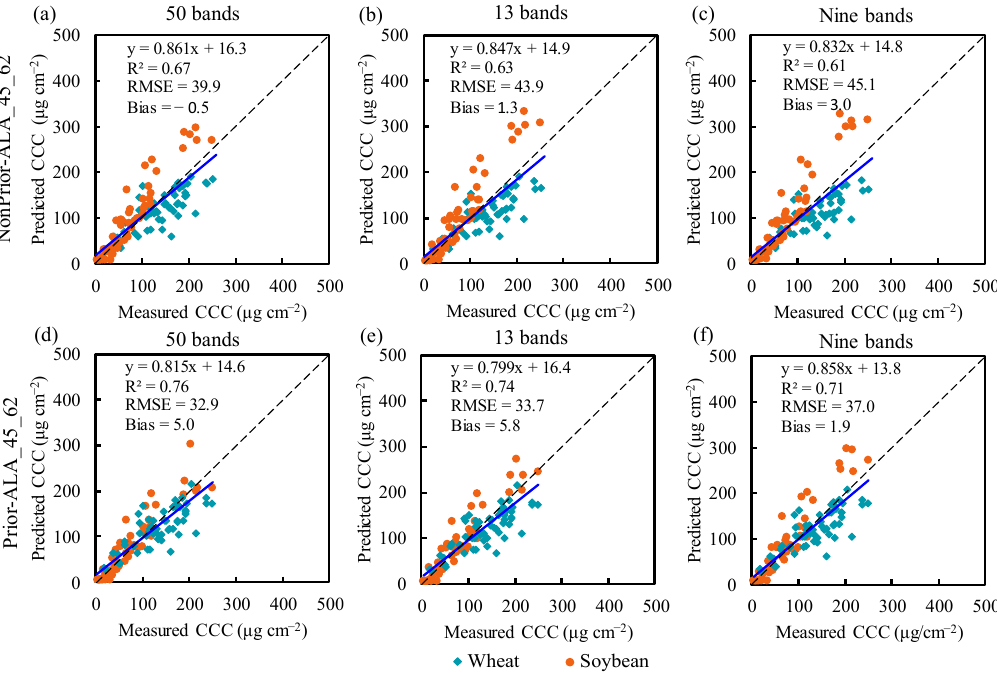
Figure 5. Scatter plots of the ground-measured and predicted CCC based on the RFR model using continuous and discrete spectra. Above: results of NonPrior-ALA_45_62 model using ( a ) 50 bands, ( b ) 13 bands, and ( c ) nine bands. Below: results of Prior-ALA_45_62 model using ( d ) 50 bands, ( e ) 13 bands, and ( f ) nine bands.